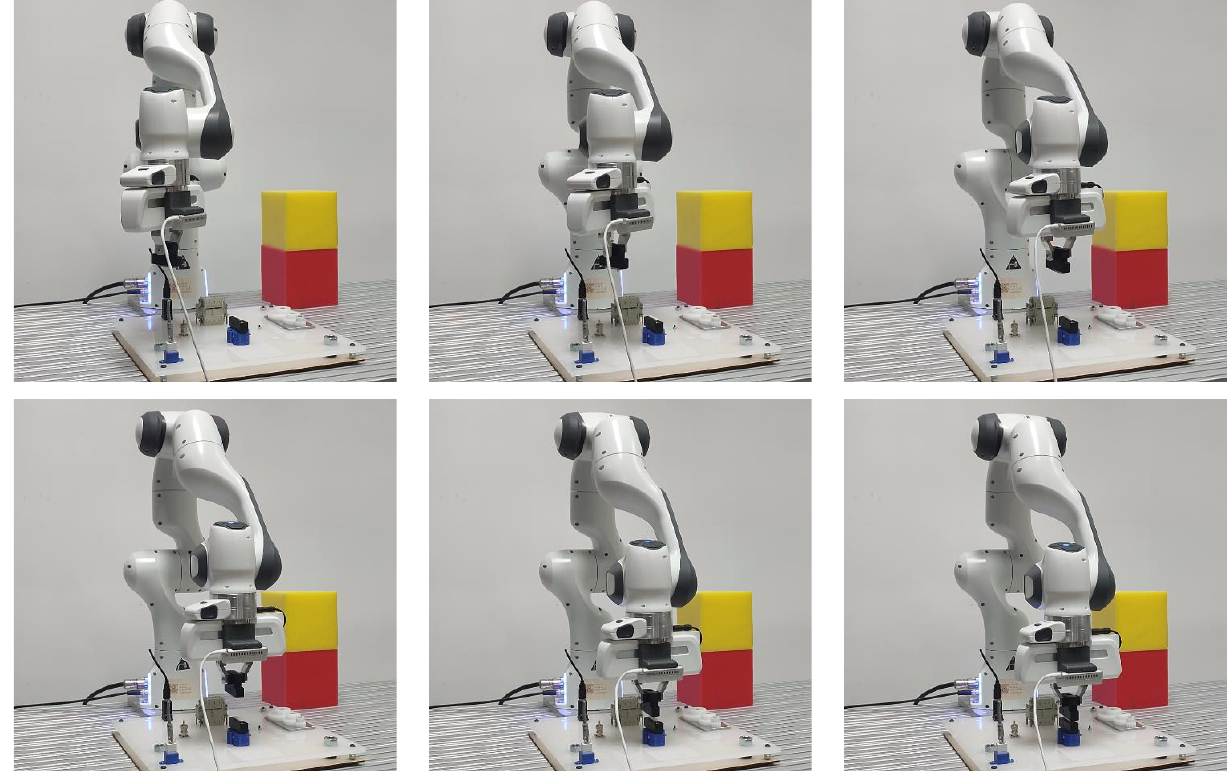
Figure 20. Snapshots of peg-in-hole experiment with DB-25.